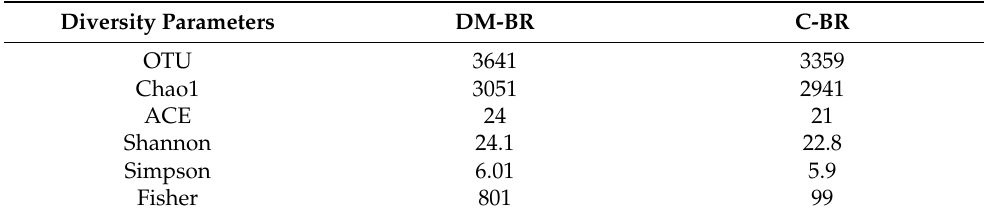
Table 4. The diversity of microbial in the DM-BR.